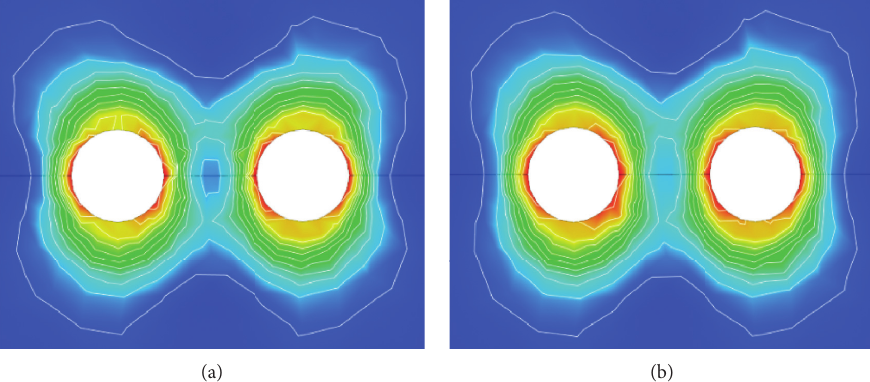
Figure 12: Cloud diagram of plastic deformation of the newly built tunnel. (a) Excavation program I. (b) Excavation program II.